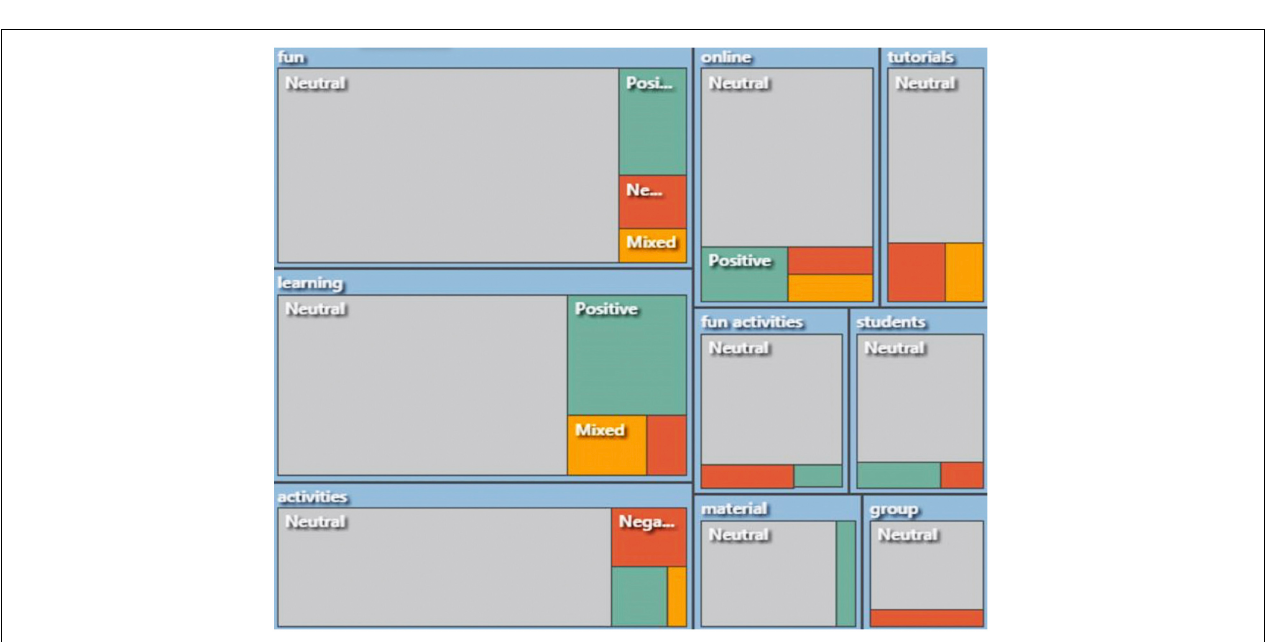
FIGURE 3 | Thematic analysis map about Online Learning and Fun with codes generated by NVivo 12.